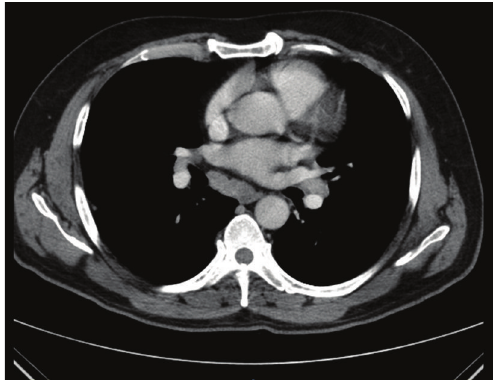
Figure 2: Bilateral hilar and subcarinal lymphadenopathy.